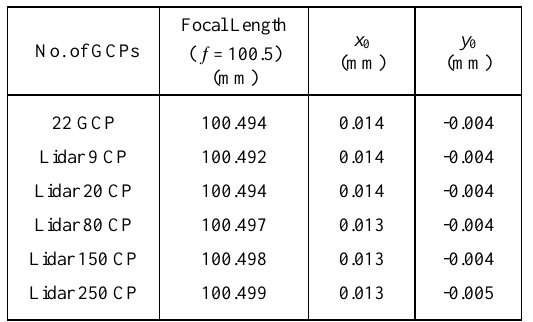
Figure 7: Elevation RMS at 50 independent check points. Due to the availability of field surveyed ground control points in the test area, an independent calibration was performed using these field surveyed control points. This was used as a benchmark to validate the calibration results obtained using differing numbers of derived LCPs. Table 2 shows reference results of camera parameters refined using 22 reference ground control points and results obtained using lidar derived control points in increasing number.